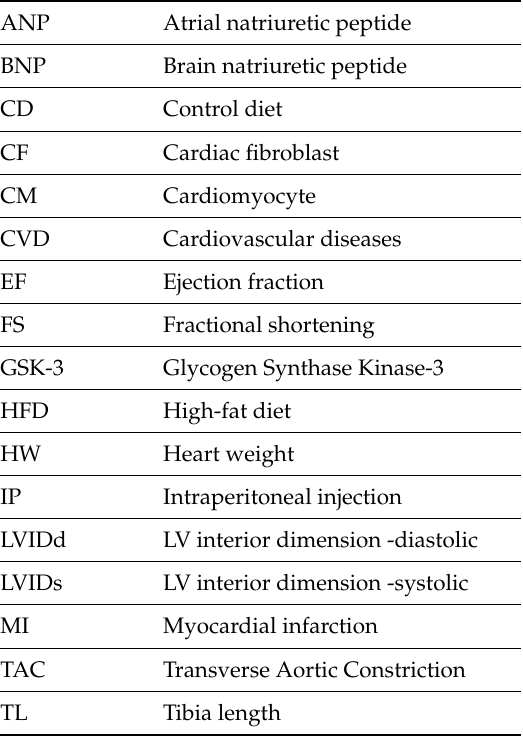
Table S1. TaqMan gene expression assays used for the quantification of fetal gene program. Table S2. Detailed list of di ff erent antibodies used and applications, Figure S1. Comparable expression of GSK-3 α / β in the skeleton muscle of controls and CM-GSK-3 β Kos, Figure S2. A strong trend of fetal gene program activation in high-fat fed CM-GSK-3 β